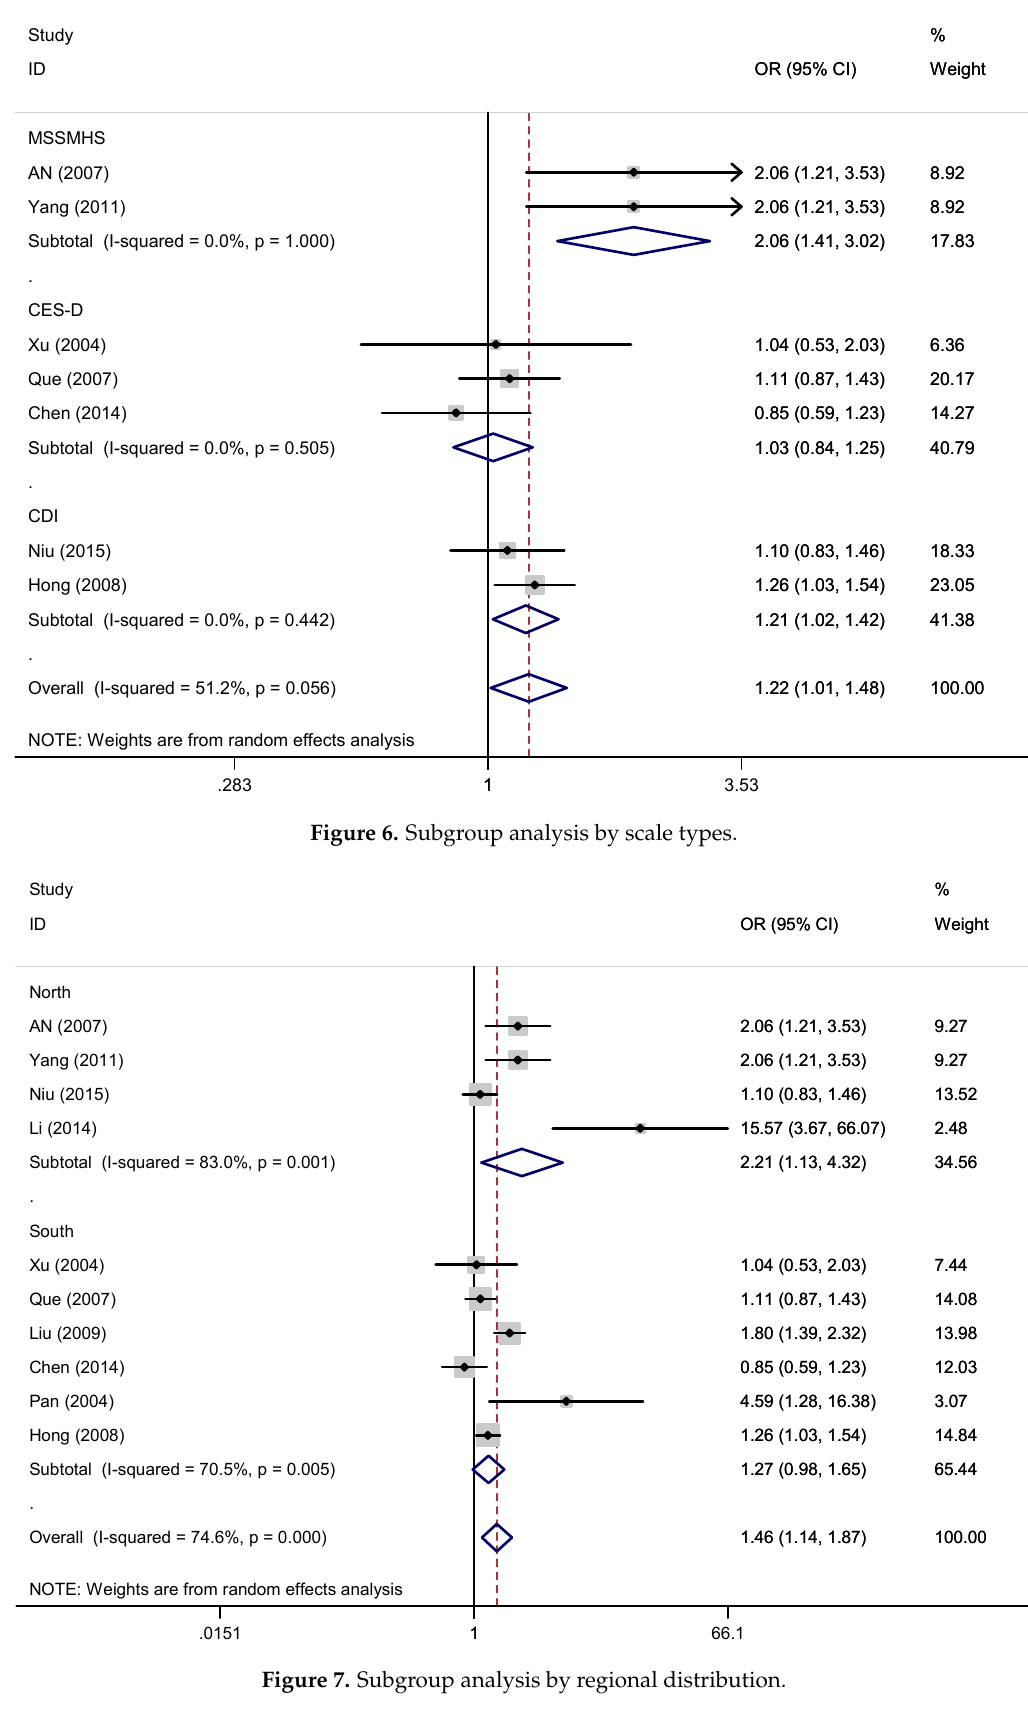
Figure 8. Subgroup analysis by age groups.